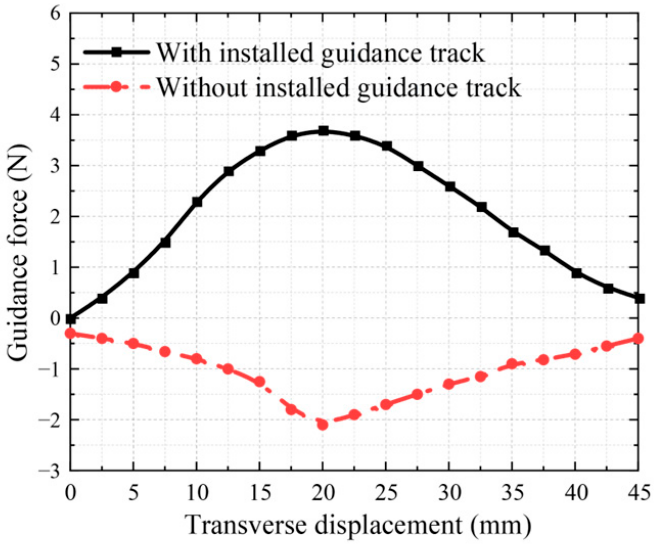
Figure 22. The experimental results of guidance forces with and without the installed guidance